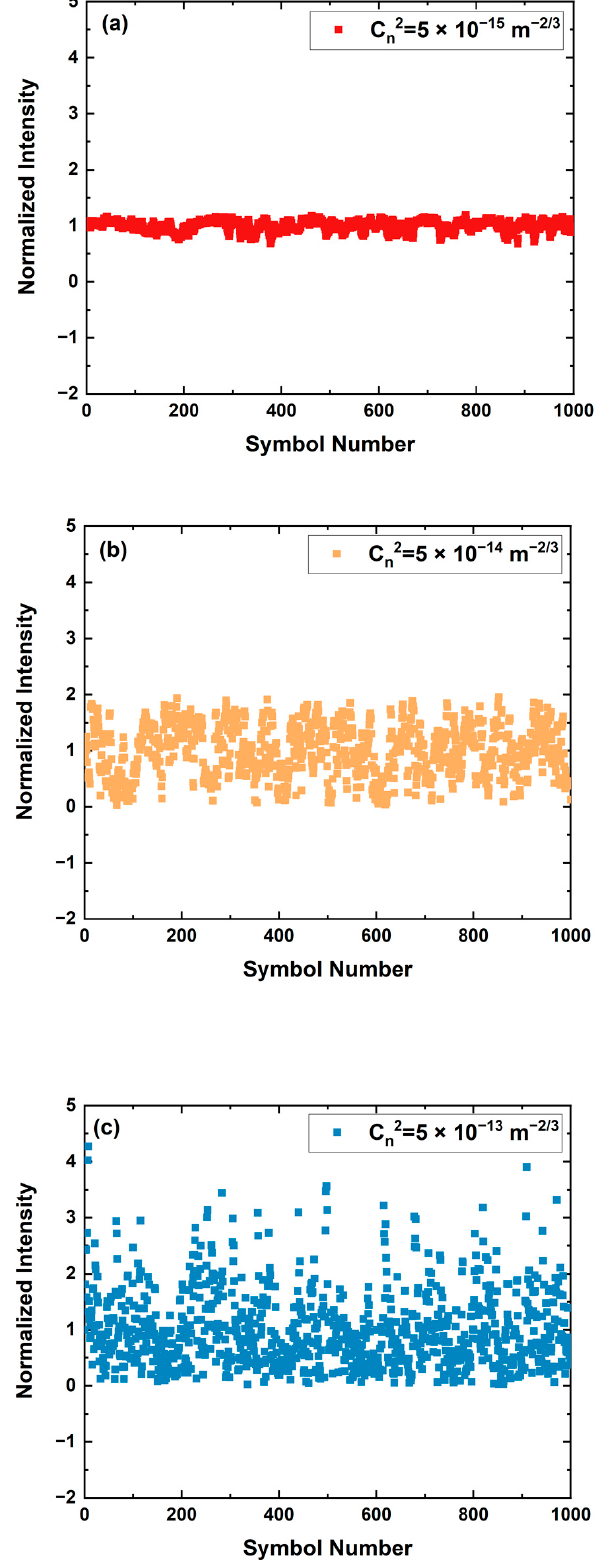
Figure 3. Normalized optical intensity variations under ( a ) weak turbulence, ( b ) moderate turbulence and ( c ) strong turbulence.